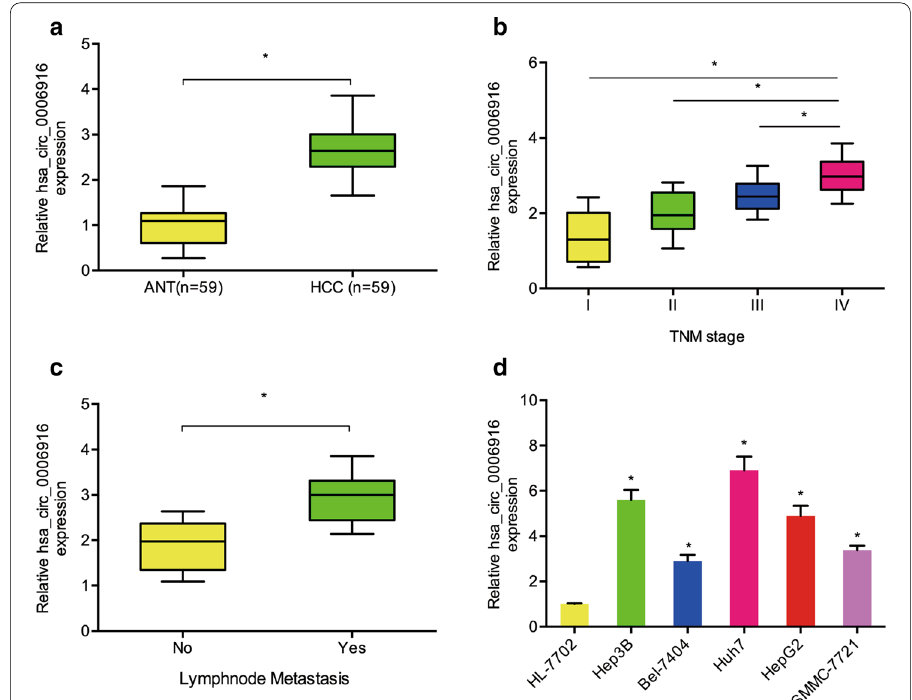
Fig. 1 Hsa_circ_0006916 is upregulated in hepatocellular carcinoma. a Hsa_circ_0006916 levels in adjacent normal tissues (ANT) and hepatocellular carcinoma (HCC) tissues. b Hsa_circ_0006916 levels in hepatocellular carcinoma at different TNM stages. c Hsa_circ_0006916 levels in hepatocellular carcinoma with or without lymph node metastasis. d Hsa_circ_0006916 levels in hepatocellular carcinoma cell lines. * p <